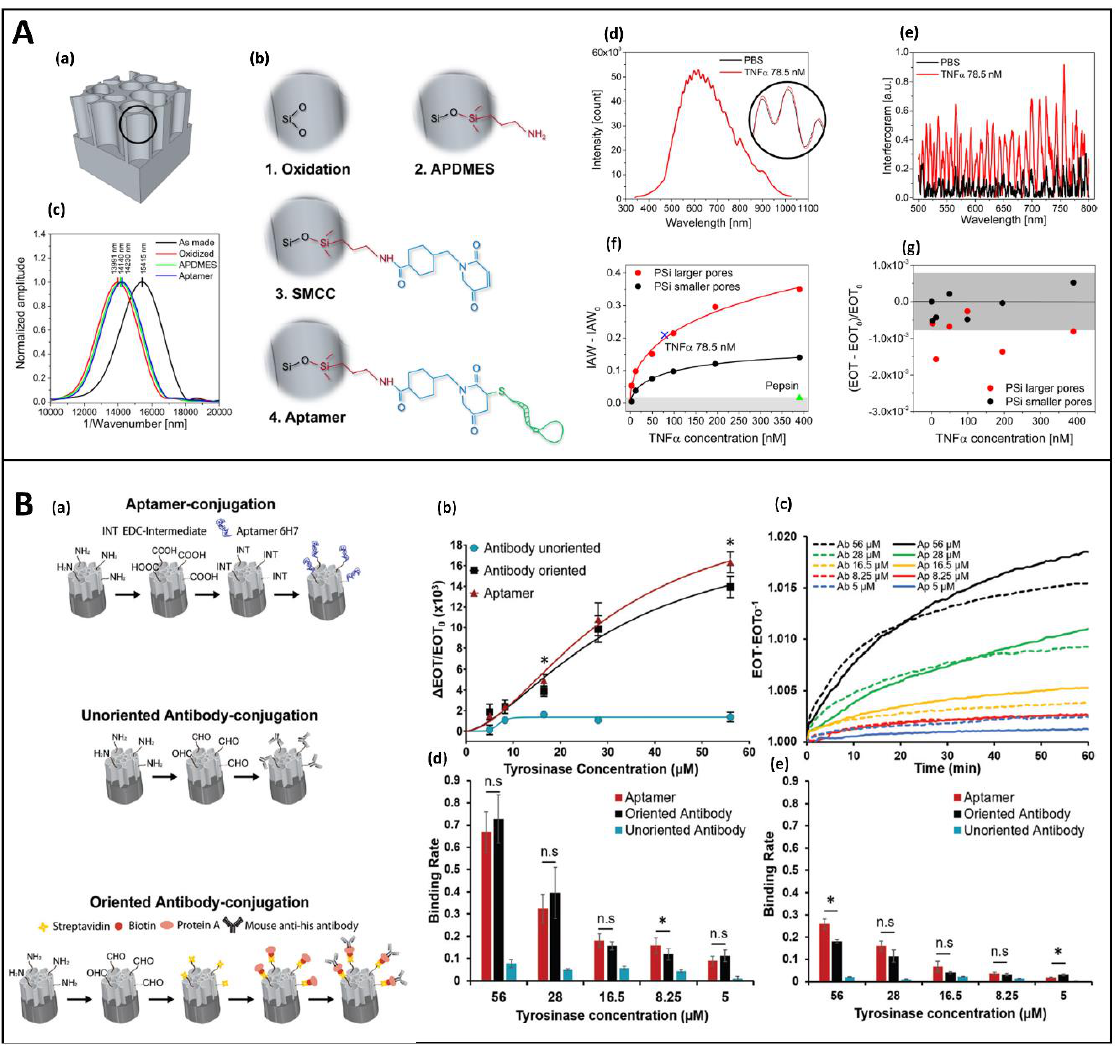
Figure 7. ( A ) (a) Cartoon of the as-prepared PSi platform. (b) Four-step protocol used to immobilize the aptamer probe into the PSi structure consisting of thermal oxidation, silanization with APDMES, grafting of SMCC, and aptamer binding; (c) FFT spectra measured after each functionalization steps; (d) reflection spectra acquired before (black line) and after injection of TNF α (red line) with (e) corresponding spectral interferogram; (f) IAW signals obtained in the range of TNF α tested (3–390 nM) for PSi with smaller (black line) and larger (red line) pores. The blank IAW 0 value is subtracted from the data; (g) calibration curve over the whole range of the tested TNF α obtaining using the EOT value as output signal. Reprinted with permission from Reference [77]; Copyright (2016) American Chemical Society. ( B ) (a) Scheme of the immobilization process of the 6H7 aptamer (upper panel) and antibodies, via random and oriented conjugation (lower panel) into PSiO 2 ; (b) EOT changes of the three type biosensors after the exposure to different concentration of his-tagged-tyrosinase; (c) EOT changes vs time of oriented antibody and aptamer onto PSiO2 upon exposure to different concentrations of his-tagged-tyrosinase; (d,e) binding rates at 10 min and 60 min obtained after the incubation of the biosensors with dif- ferent concentrations of tyrosinase. (ns) or (*) indicate the non-significant or statistically significant difference, respec-tively, between the total binding or the binding rate of the oriented antibody and aptamer-based biosensors. Reprinted with permission from Reference [133]; Copyright (2020) The Royal Society of Chemistry